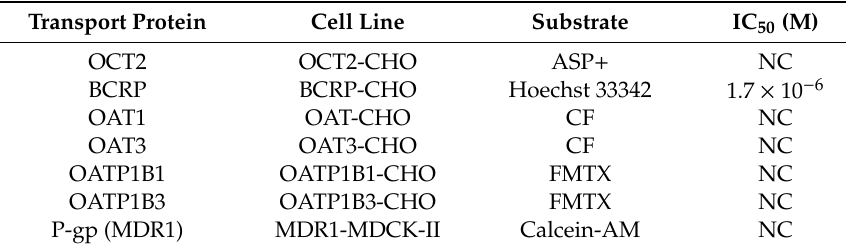
Table 2. Summary of drug transporter